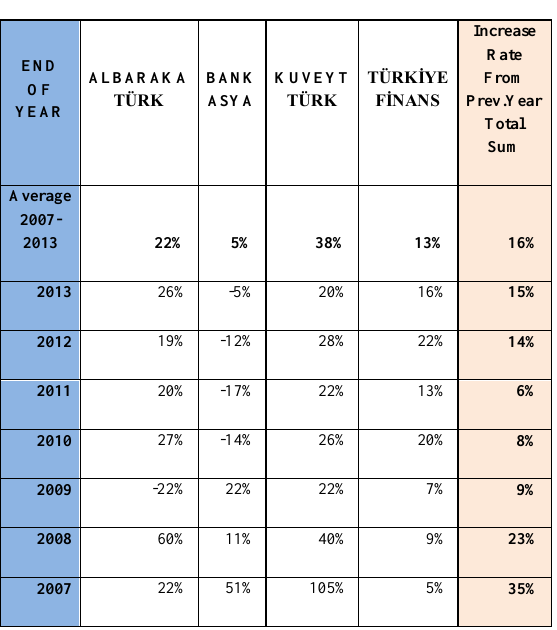
Table-12/b: Increase Rate from Previous Year at Net Profit, 2007-2013 (1000TL)